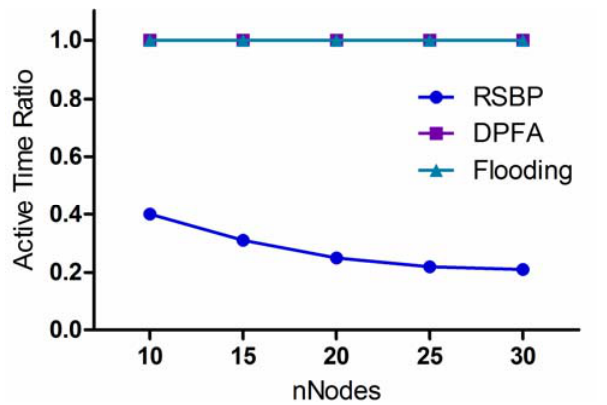
Figure 10. Active Time Ratio.